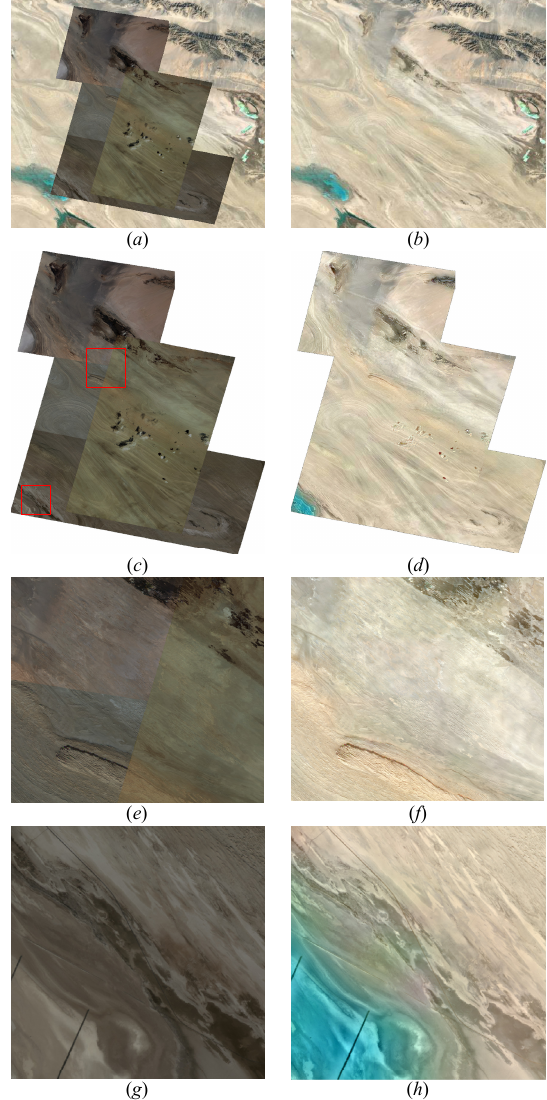
Figure 6. Color correction results of Experiment 2. ( a ) is overlay schematic of input images and the reference image, ( b ) is the external reference image, ( c-h ) is the images before and after color correction.